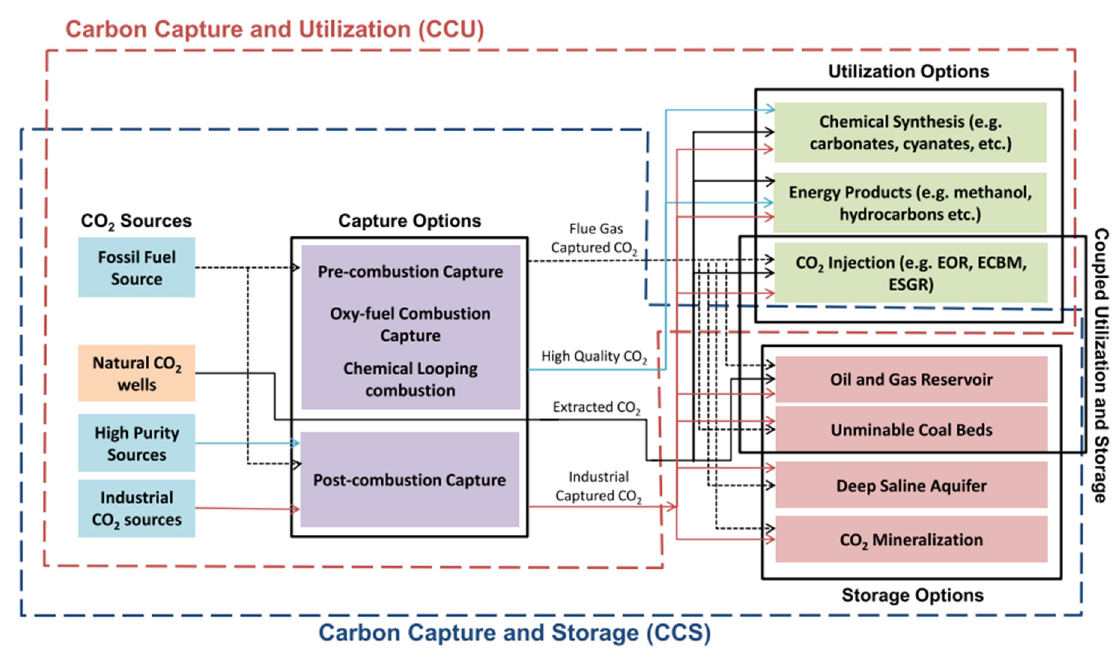
Figure 8. CCUS structure with different storage and utilization paths [34]. Reprinted with permission from Elsevier.